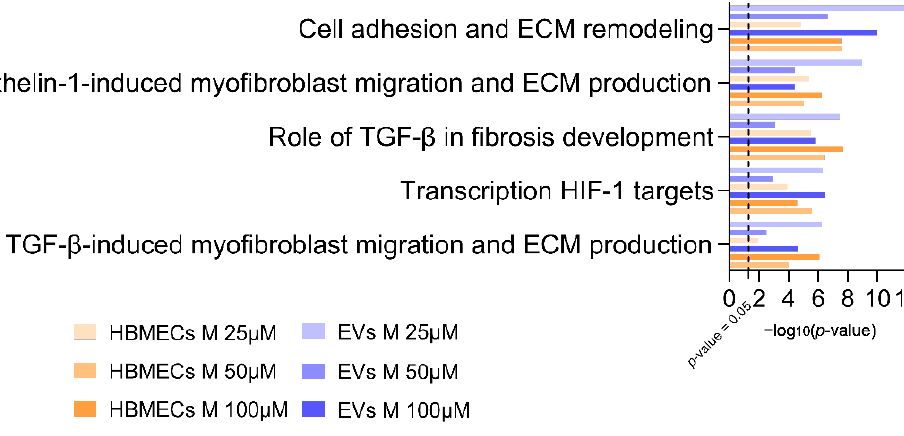
Figure 4. Pathway enrichment analysis of modulated proteins in morphine-treated human brain endothelial cells and associated extracellular vesicles. Top five enriched pathways in both total cells and EVs upon 25, 50 and 100 µ M of morphine for 24 h (|FC|> 1.2, p -value ≤ 0.05, n = 3). X-axis corresponds to − log 10 ( p -value), Y-axis corresponds to the biological pathways and the dot line represents the p -value cut-off of 0.05. HBMECs = human brain microvascular endothelial cells, EVs = extracellular vesicles.